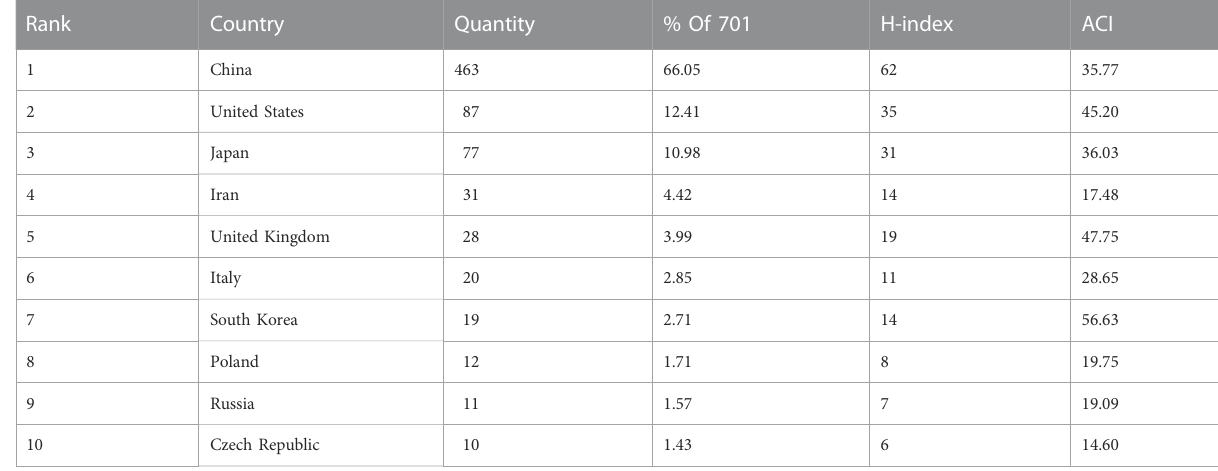
TABLE 1 The top 10 countries in research scope of